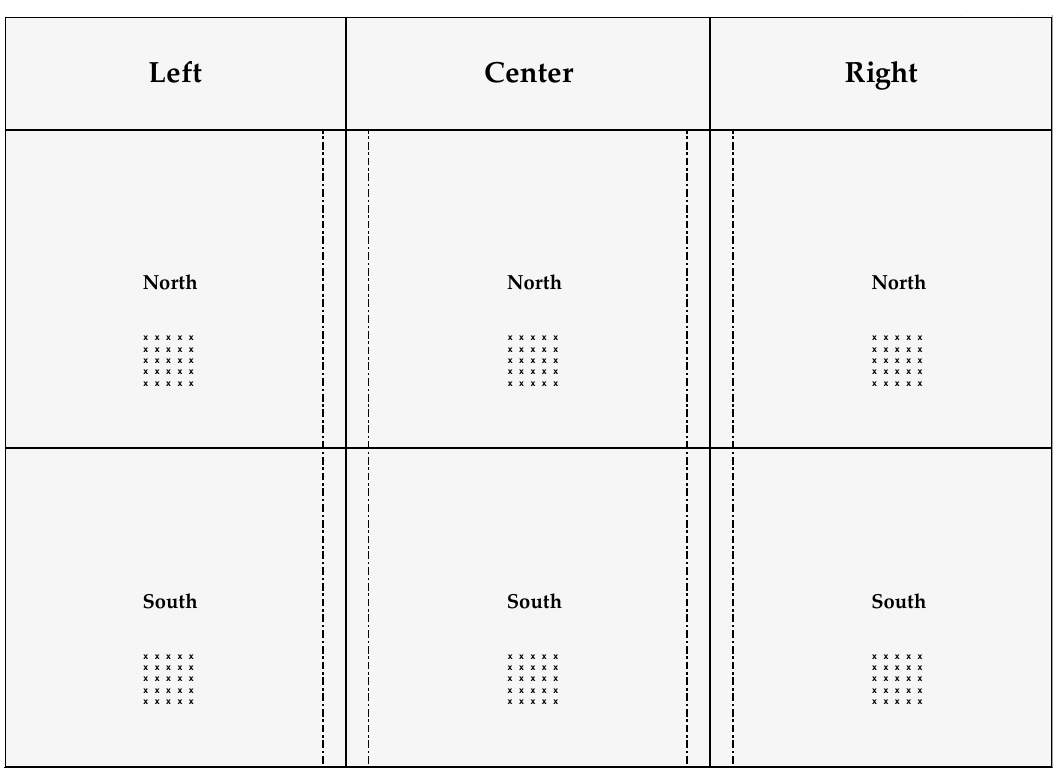
Figure 8. Permeability test locations, marked in red, on each type of the pavement pad.